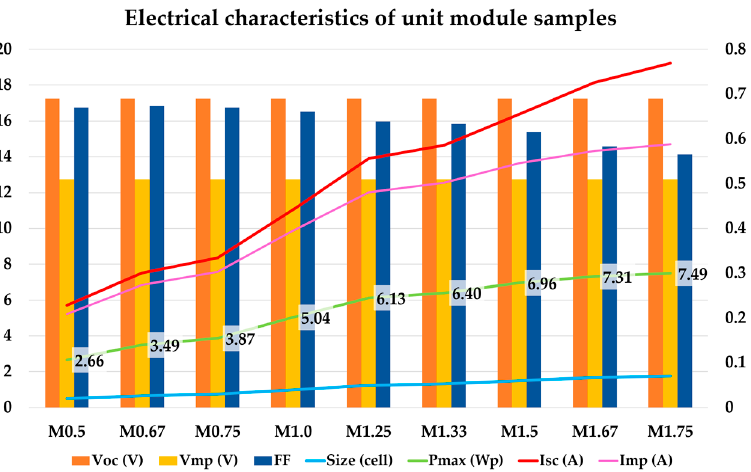
Figure 10. Comparison chart of estimated values and experimental values of samples S1-S4.